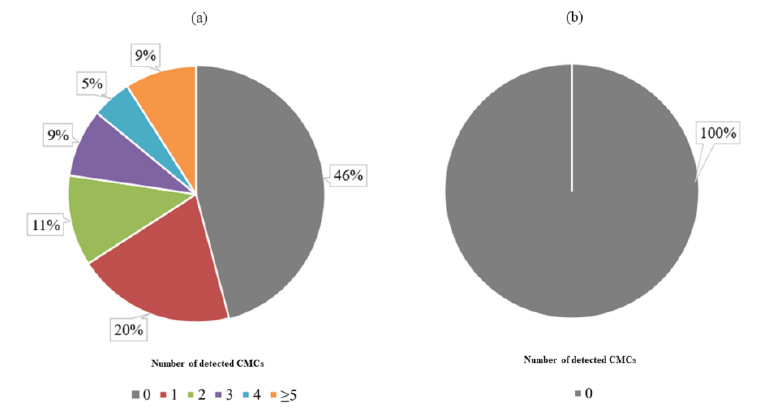
Figure 3. Distribution of detected circulating melanoma cells (CMCs) using the CellSearch ® system ( a ) among patients and ( b ) in the control group.